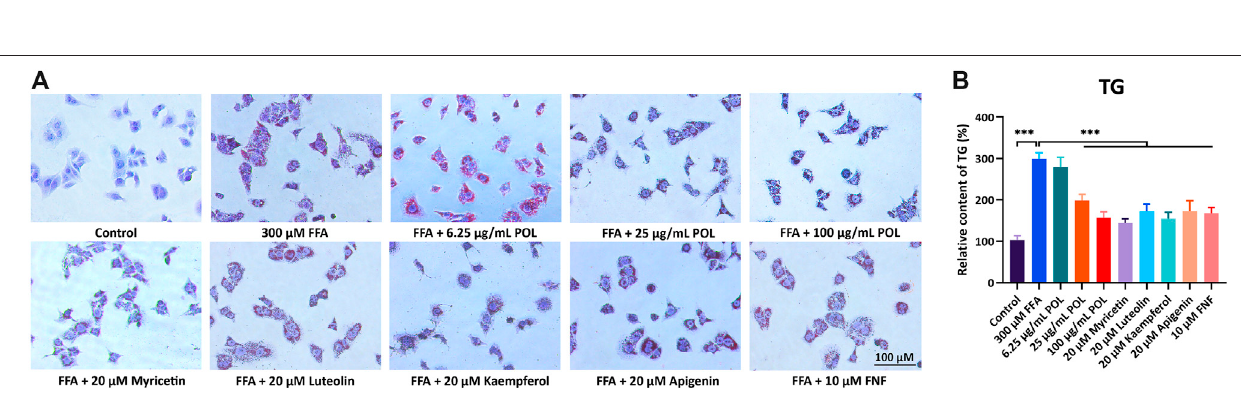
Frontiers in Pharmacology |